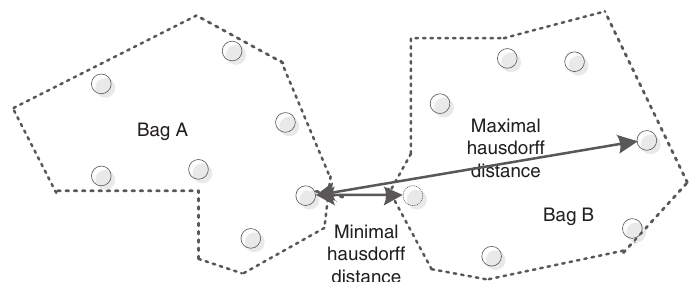
Figure 1: Minimal and Maximal Hausdorff